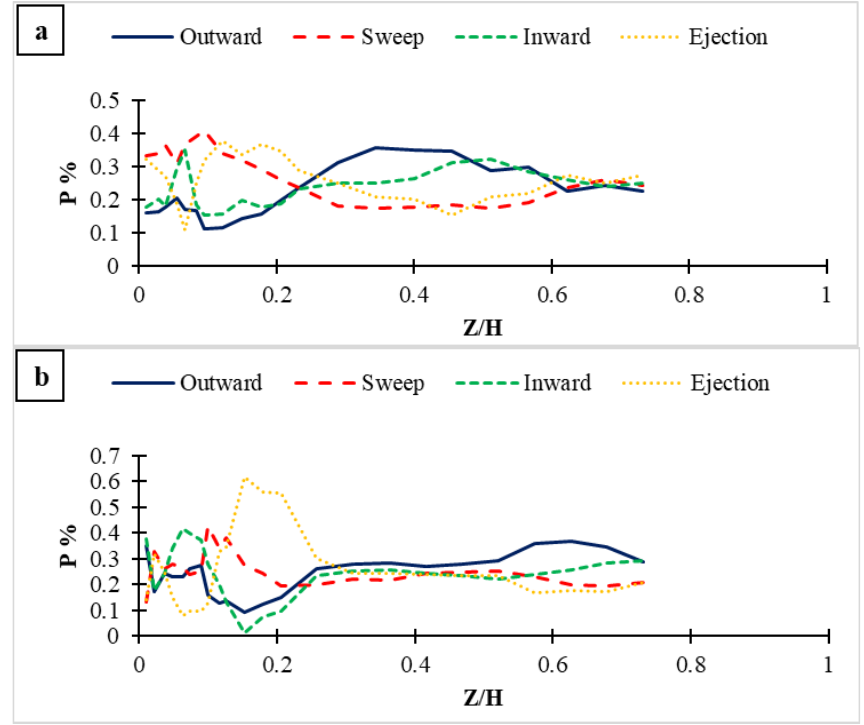
Figure 9. Contribution of each event in the central axis of the river in: ( a ) the pool and ( b ) the riffle.